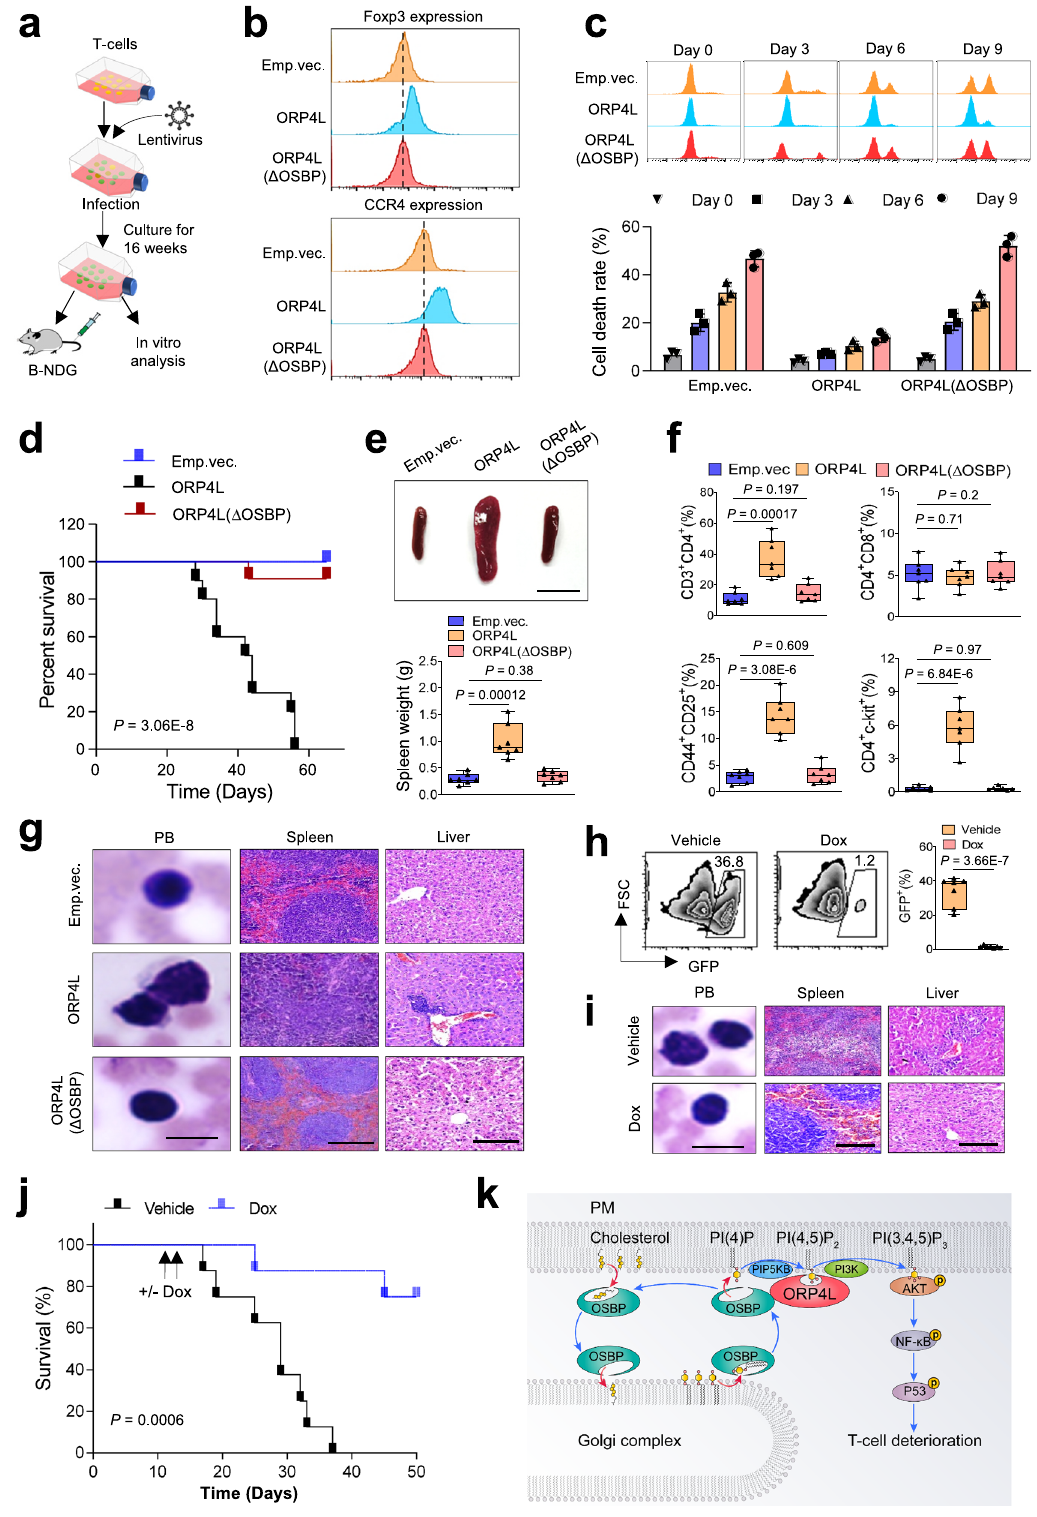
(Cedarlane) according to the manufacturer ’ s instruction and